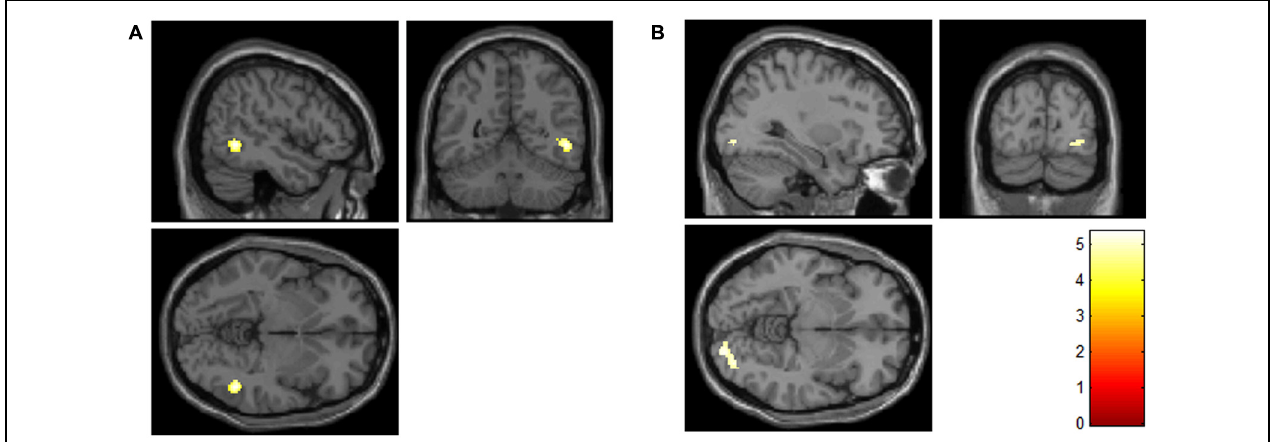
FIGURE 1 | Increased activity in the anorexia nervosa (AN) group compared to the control group in the right inferior and middle temporal gyri (A), and the right lingual gyrus (B) for participants’ own faces